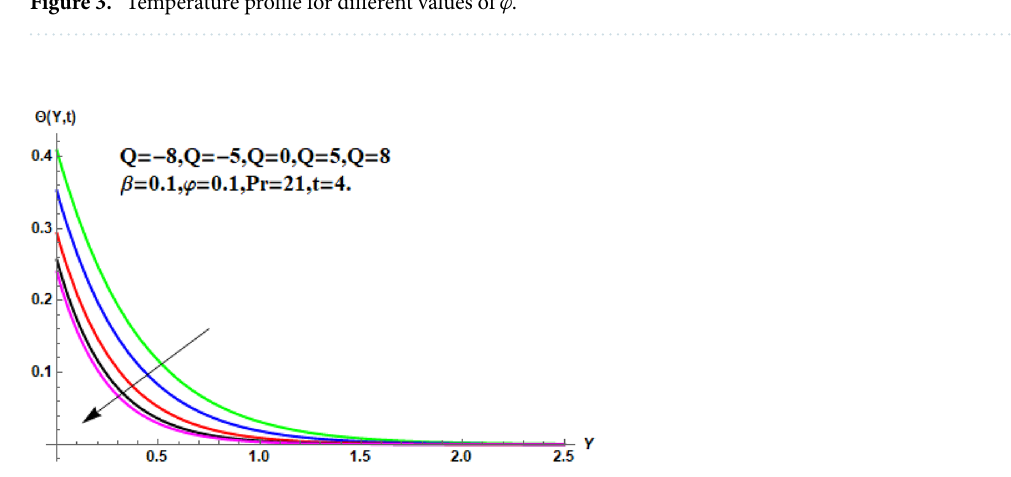
Figure 4. Temperature profile for different values of Q